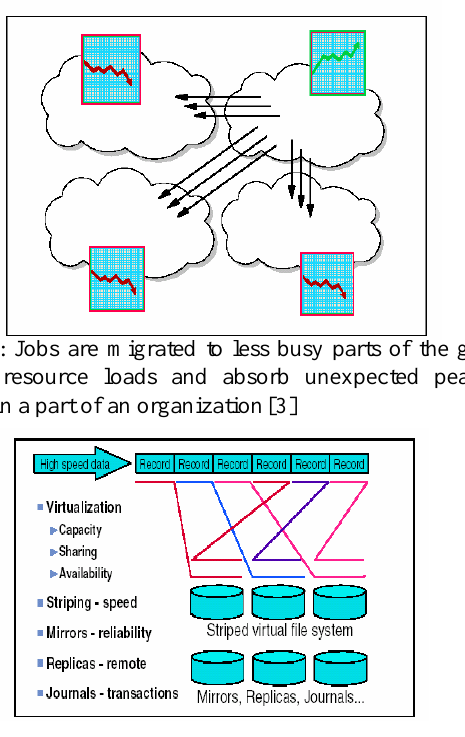
Figure 4: Data stripping is writing or reading successive records to/from different physical devices, overlapping the access for faster throughput additional technique increase reliability. [3]